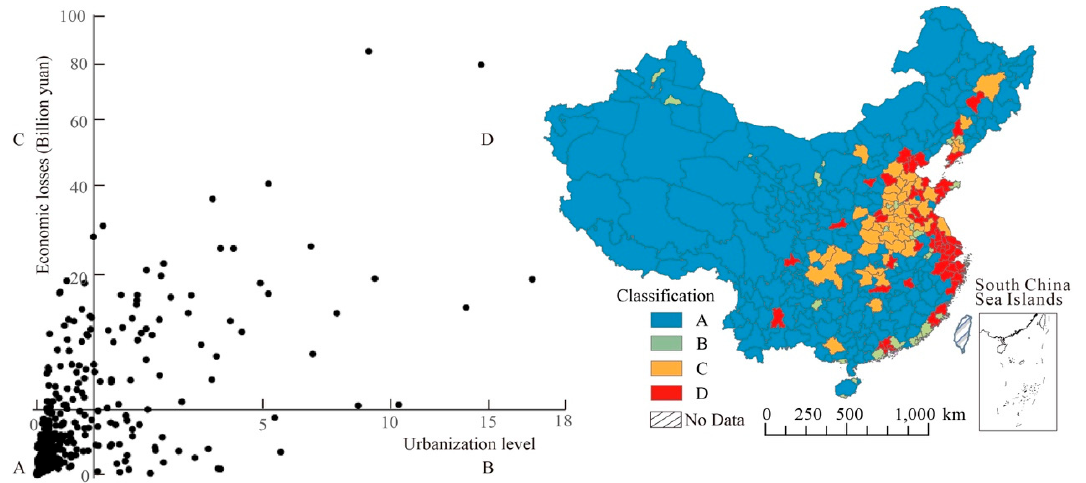
Figure 7. Classification results and distribution of different cities (A is non-key area, B for successful region, C is potential zone, and D represent key area).